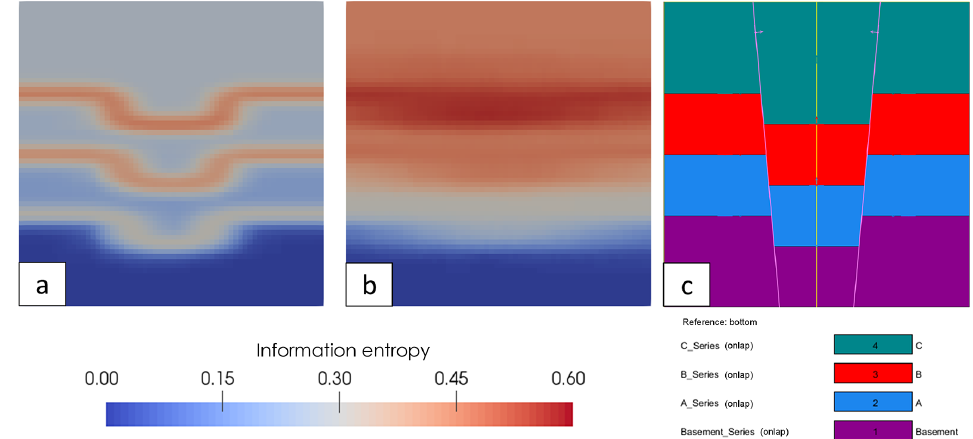
Figure 9. Effect of pole (a) versus dip (b) perturbation for a graben model (c) ; orientations are perturbed over a vMF distribution with κ = 100.